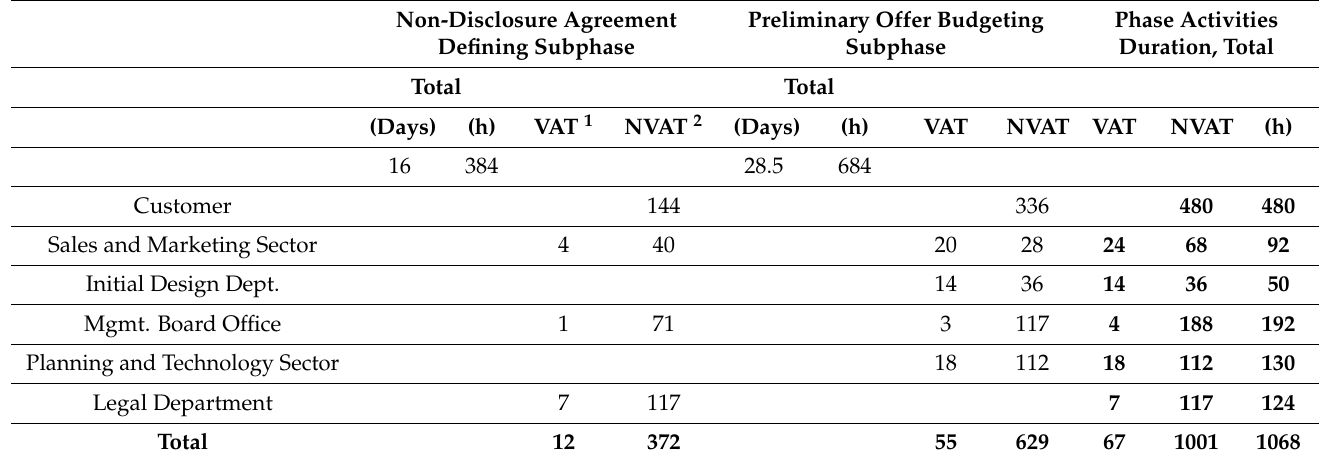
Table A3. The average durations of the Preliminary offer preparation phase activities—the current state.